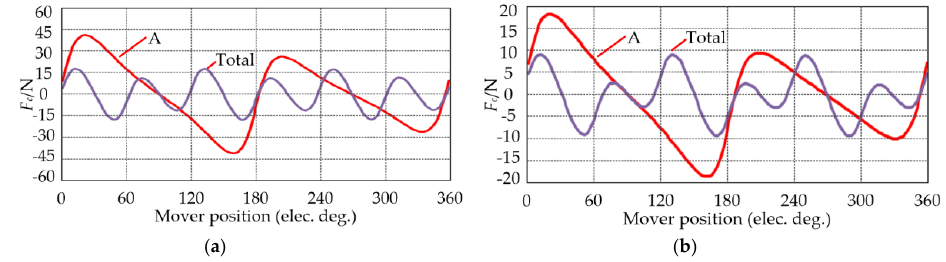
Figure 12. The waveform of the detent force: ( a ) The conventional TTFFRLM; ( b ) The primary consequent-pole TTFFRLM. consequent-pole